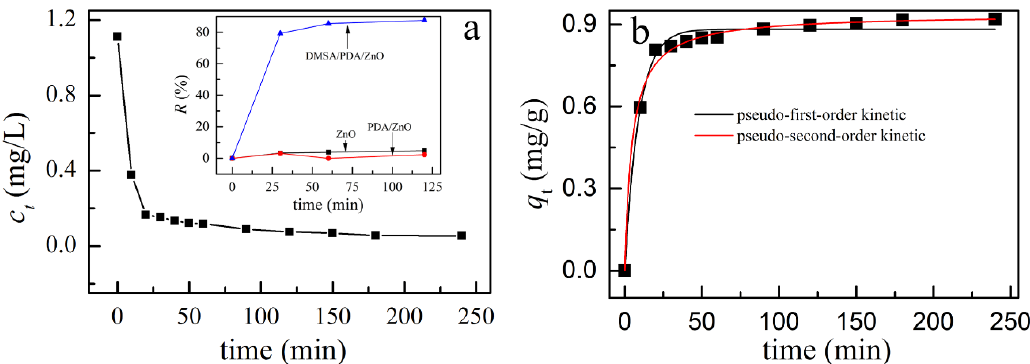
(Table 2). The pseudo-second-order reaction rate constant was 0.22 g / (mg • min.). Appl. Sci. 2020 , 10 , x FOR PEER REVIEW